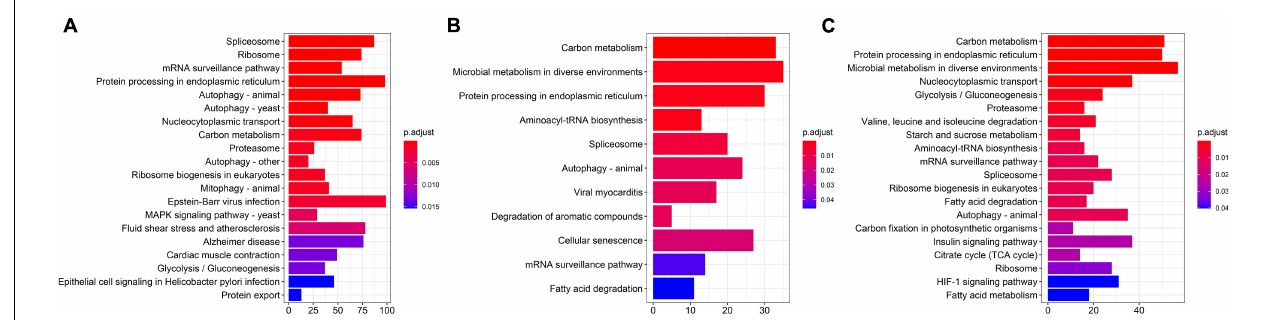
FIGURE 6 | KEGG enrichment results of differential alternative splicing genes (DASGs) at different low temperatures. (A–C) Represented KEGG enrichment results at 13, 15, and 17 ◦ C,